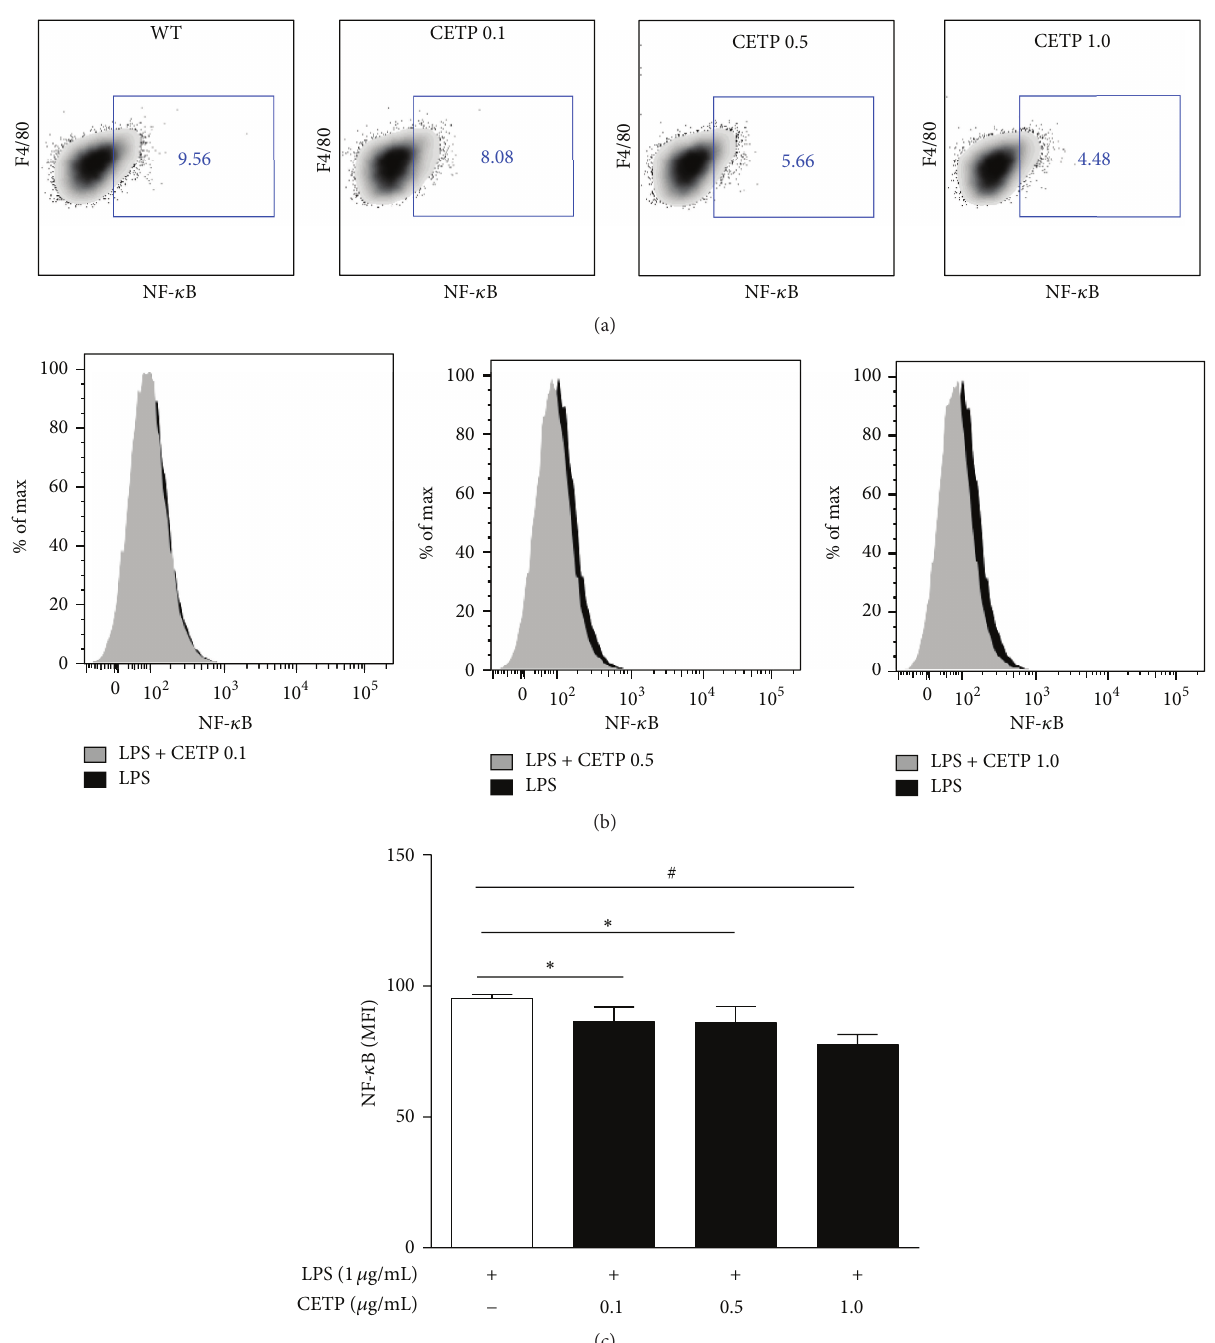
Figure 7: CETP reduces LPS-stimulated transcription factor NF- 𝜅 B activation. Peritoneal macrophages obtained from WT mice were stimulated for 24 h with LPS-Alexa Fluor 488 (1 𝜇 g/mL) in the absence or presence of CETP (0.1, 0.5, and 1.0 𝜇 g/mL). (a) Representative FACS dot plots gated on F4/80 + cells (macrophages only) and the percentage of NF- 𝜅 B + cells are shown. (b) Representative flow cytometry histograms of NF- 𝜅 B comparing macrophages (F4/80 + ) from WT and respective CETP groups stimulated with LPS. (c) Graph presented as mean ± SD of MFI (median fluorescence intensity) analyzed using FACSDiva software ( 𝑛 = 4) representative of three independent experiments, by one-way ANOVA 𝑝 = 0.0019 and posttest (Newman-Keuls Multiple Comparison Test; ∗ 𝑝 < 0.05 and # 𝑝 < 0.01